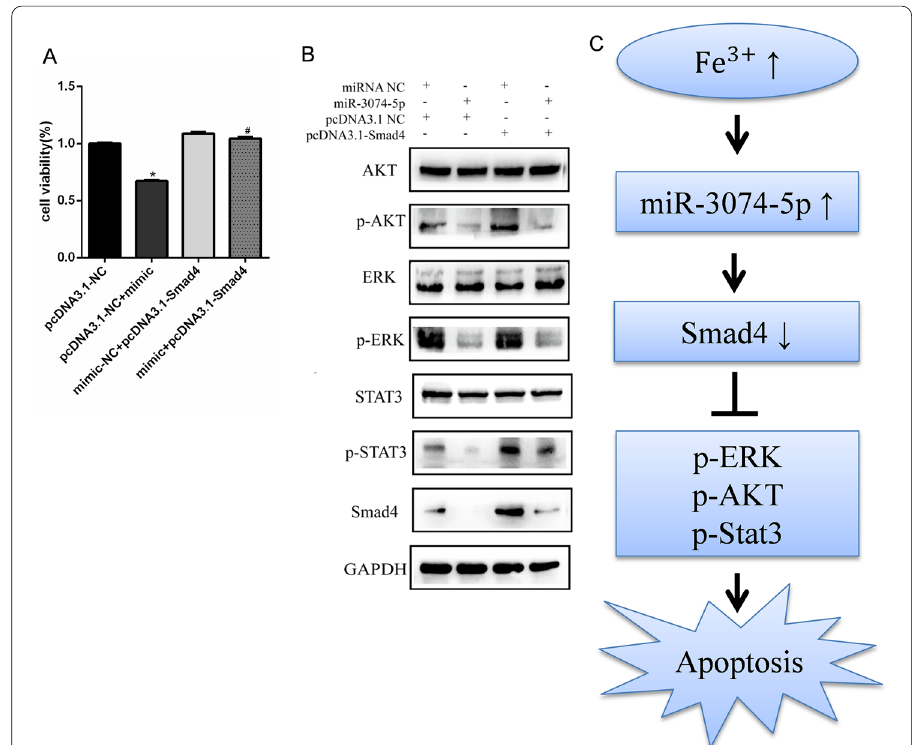
Fig. 5 Restoration of Smad4 can rescue the effects of miR‑3074‑5p on MC3T3‑E1 cells. A Gain‑ and loss‑of‑function experiments were performed by transfecting cells with pcDNA3.1‑Smad4 and the miR‑3074‑5p mimic, respectively. The CCK‑8 assay was used to evaluate the effect of Smad4 on cell viability. * P < 0.05 vs. the pcDNA3.1‑NC. # P < 0.05 vs. the pcDNA3.1‑NC mimic group. B Apoptosis‑related protein + expression levels of cells were evaluated by western blot analysis. C Working model of miR‑3074‑5p‑mediated apoptosis in iron‑overloaded MC3T3‑E1 cells. miR‑3074‑5p expression was significantly increased in MC3T3‑E1 cells under iron overload conditions. Overexpression of miR‑3074‑5p induced downregulation